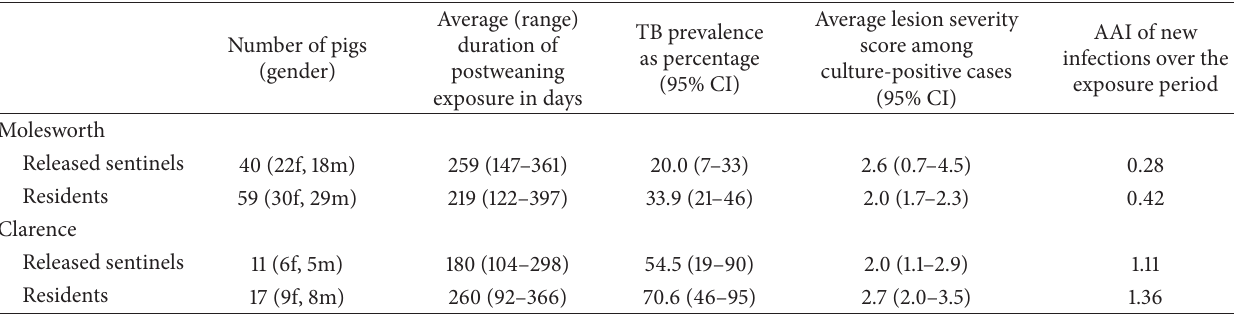
Table 3: Comparison of TB prevalence rates among released sentinel and resident wild pigs in the Molesworth and Clarence study areas, following the release and recovery of 51 M. bovis -na¨ıve sentinel pigs into the areas between May 2009 and July 2010.